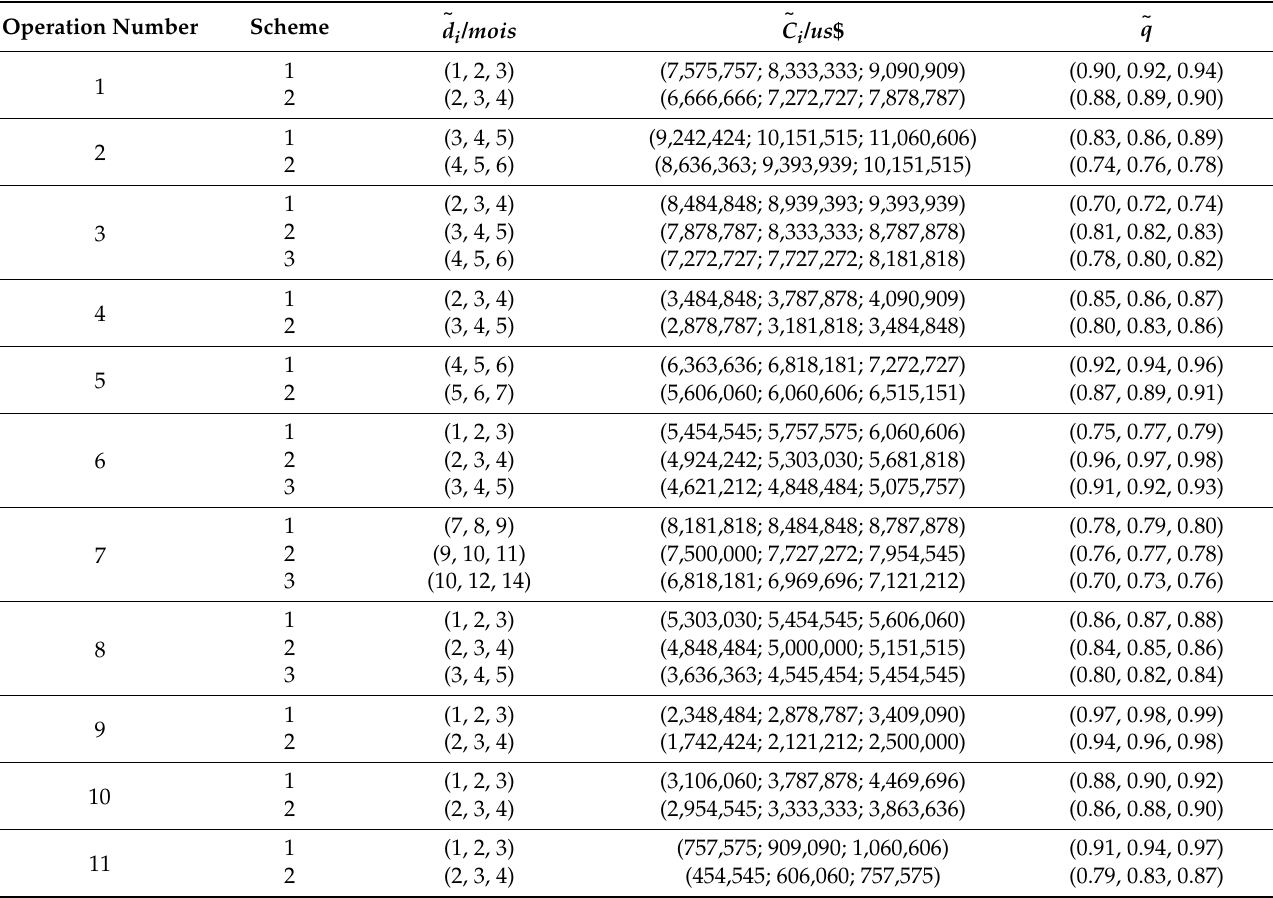
Table 4. Relevant parameters and data of each operation (for the engineering application of the concrete-face rockfill dam project).